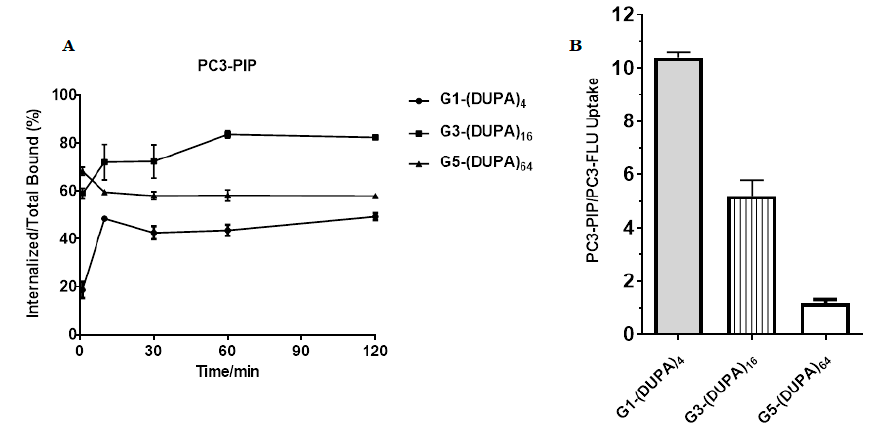
Figure 2. In vitro cell assays. ( A ) Internalization of the 64 Cu-labeld dendrimers in PC3-PIP cells. ( B ) The cellular uptake ratio of the 64 Cu-labeld dendrimers in PC3-PIP (PSMA + ) and PC3-FLU (PSMA − ) cells ( n = 3).